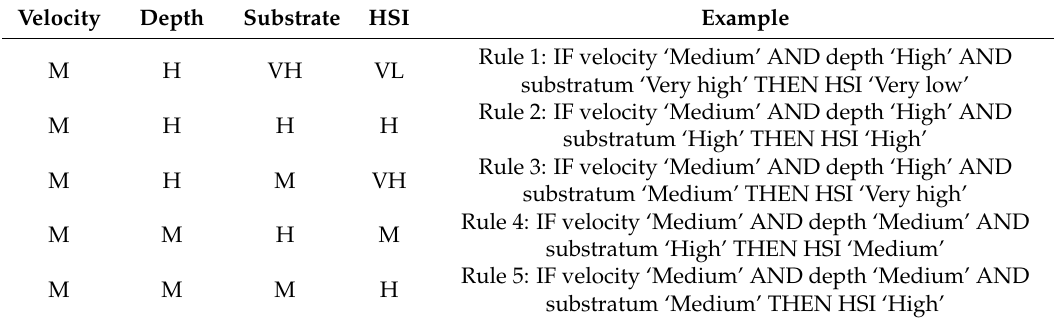
Table 3. Example of a fuzzy rule set describing the habitat requirements of the European grayling for adult fishes in the Isar River